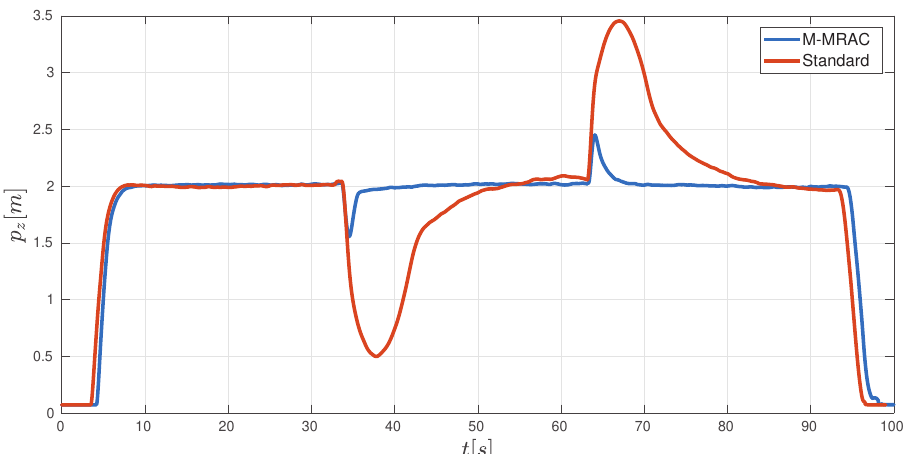
Figure 9. Real system comparison of the UAV performing a position controlled flight whilst changing the weight.